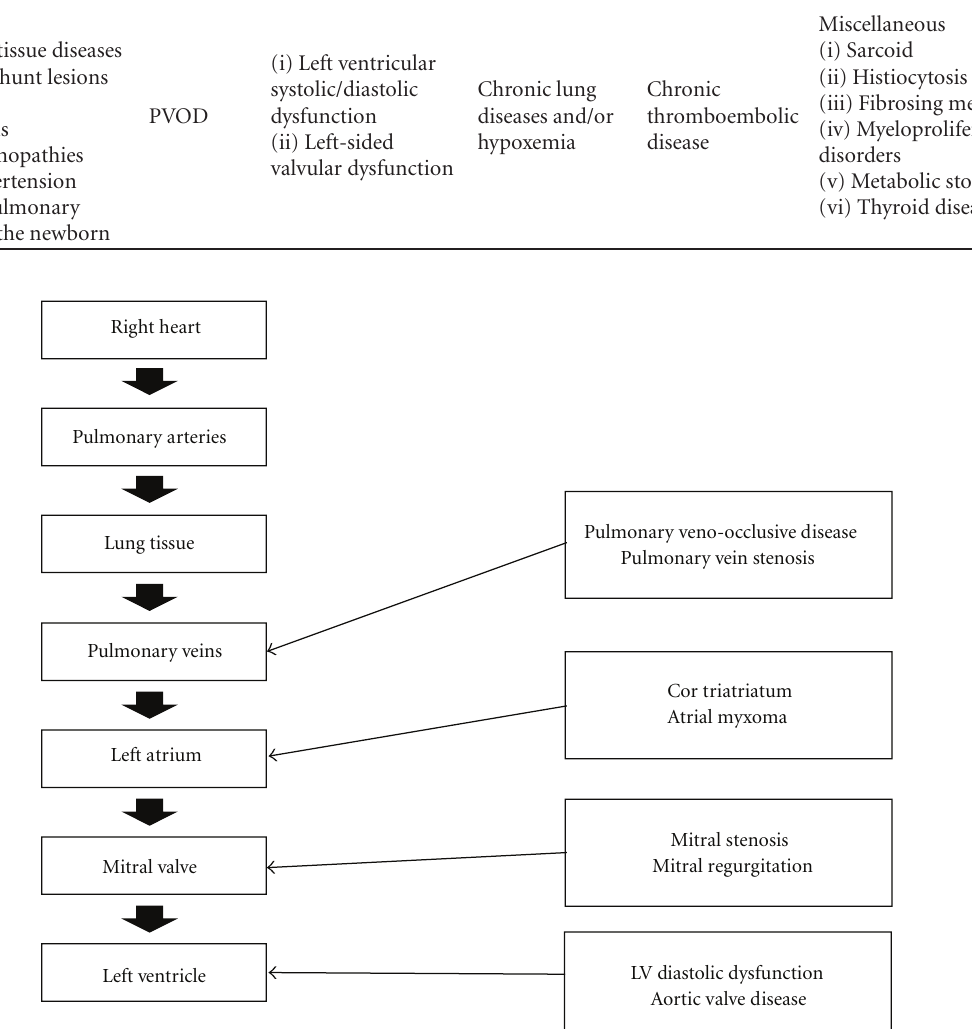
Figure 1: Anatomic organization of left heart causes of pulmonary hypertension from the right ventricle through the lungs to the left ventricular outflow